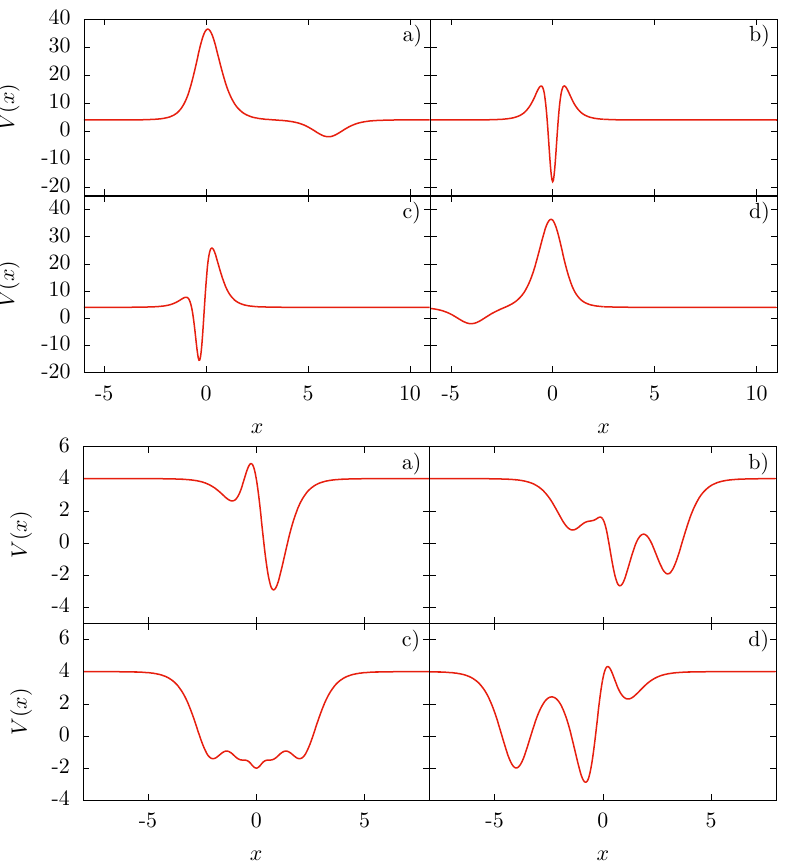
Figure 3 . Potential V ( x ) in the spectral problem for the (cid:30) 4 BPS-impurity model (4.11). Left : (cid:11) = 2 and x 0 = 10 ; 2 ; 1 ; 4. Right : (cid:11) = (cid:0) (cid:0) (cid:0)